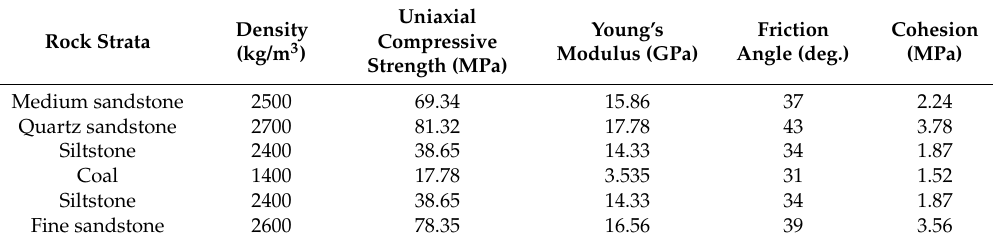
Figure 10. Stress distributions on the entry sides: ( a ) Monitoring results for the non-fracturing side; ( b ) Monitoring results for the fracturing side.